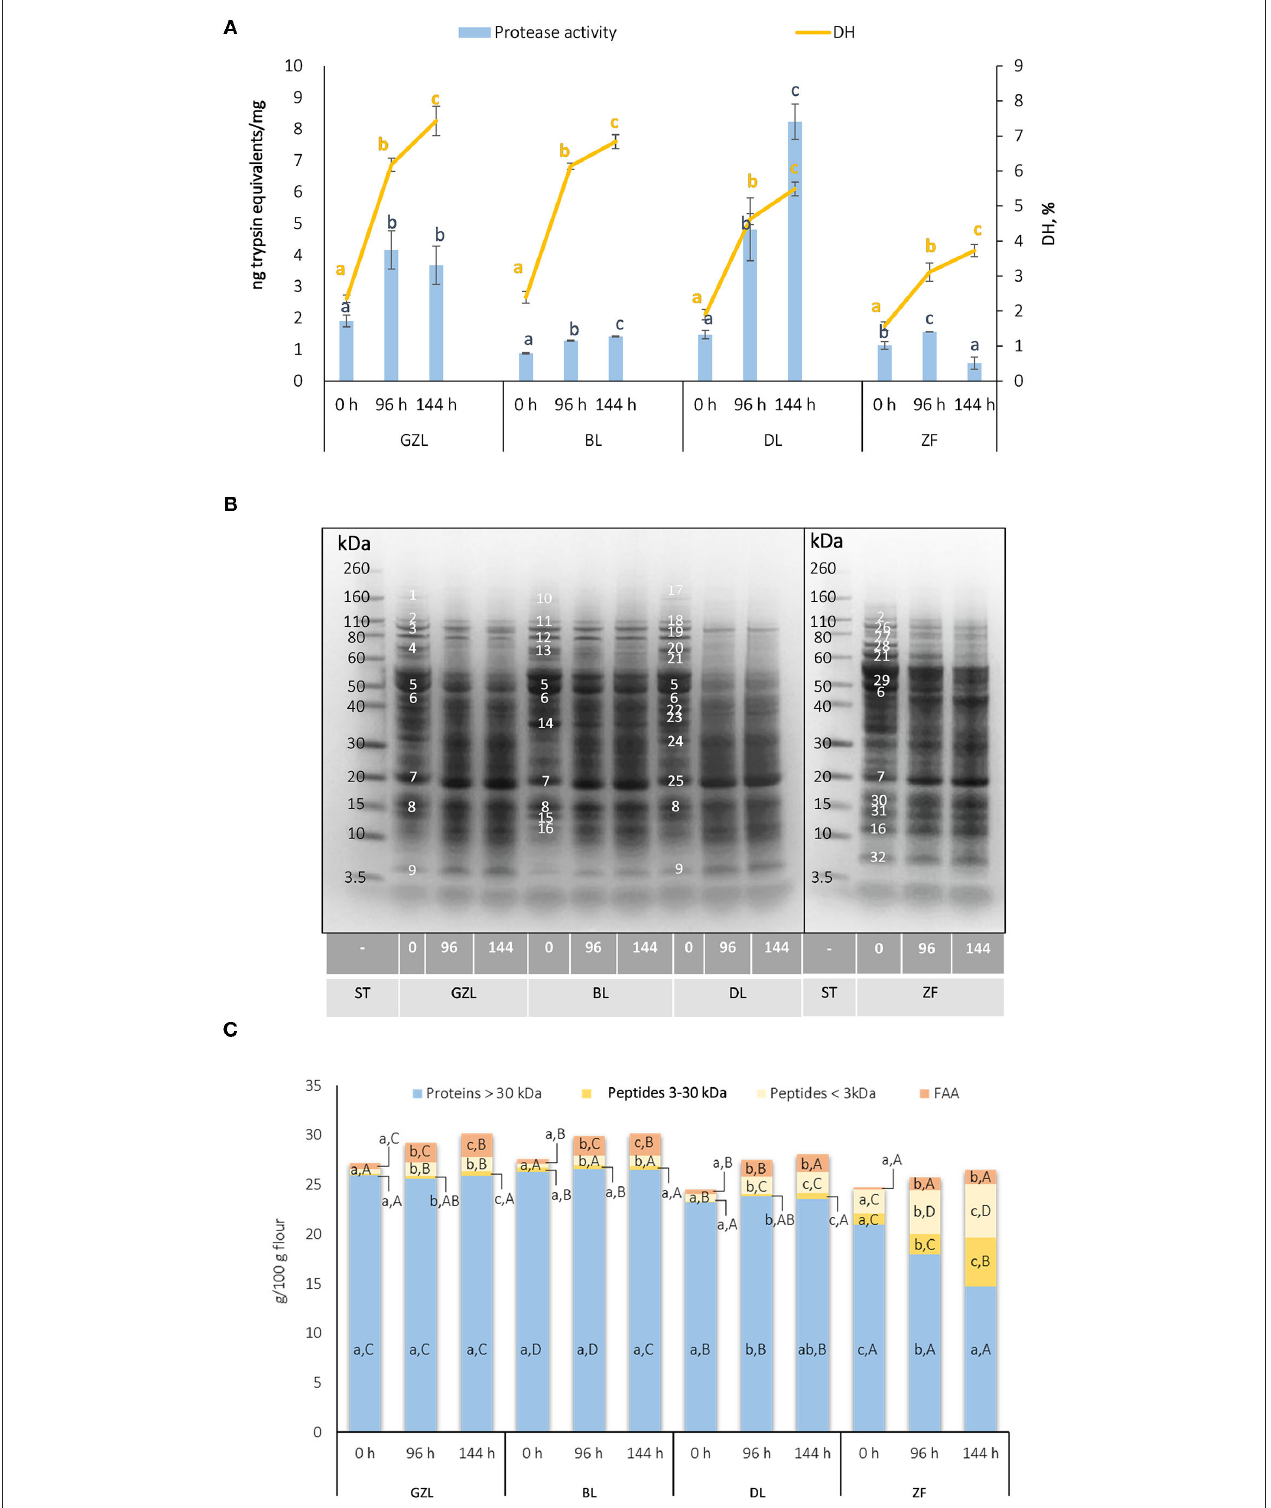
FIGURE 1 | (A) Protease activity and the degree of protein hydrolysis (DH) in ungerminated (0h) and sprouted lentil and fava bean seeds at different germination times (96 and 144h). Data are the mean ± SD of the three replicates. Different uppercase letters denote statistical differences among legumes at the same germination